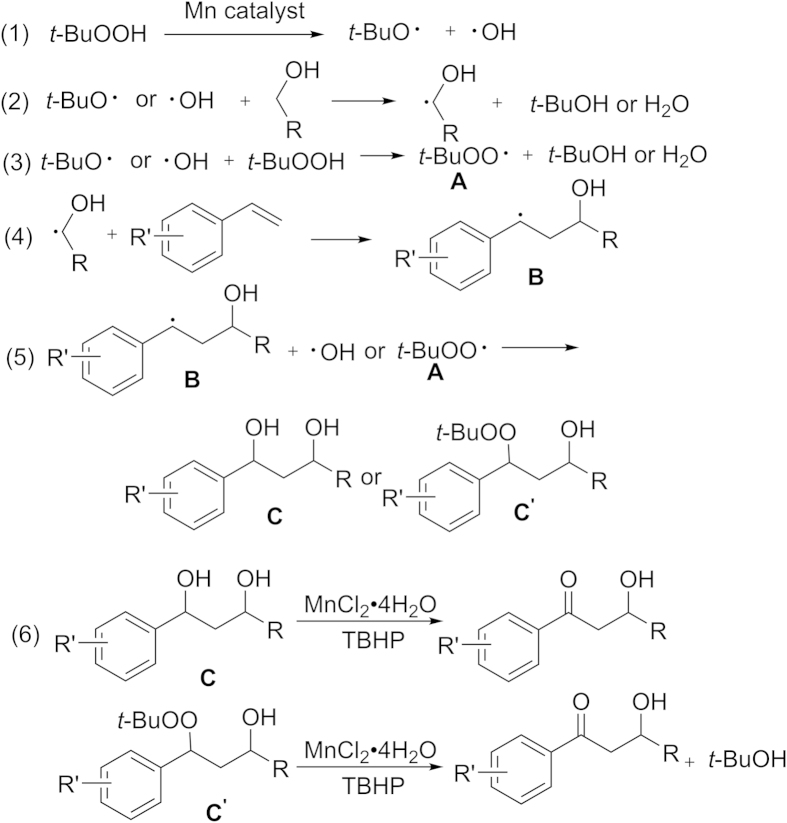
Proposed mechanism.